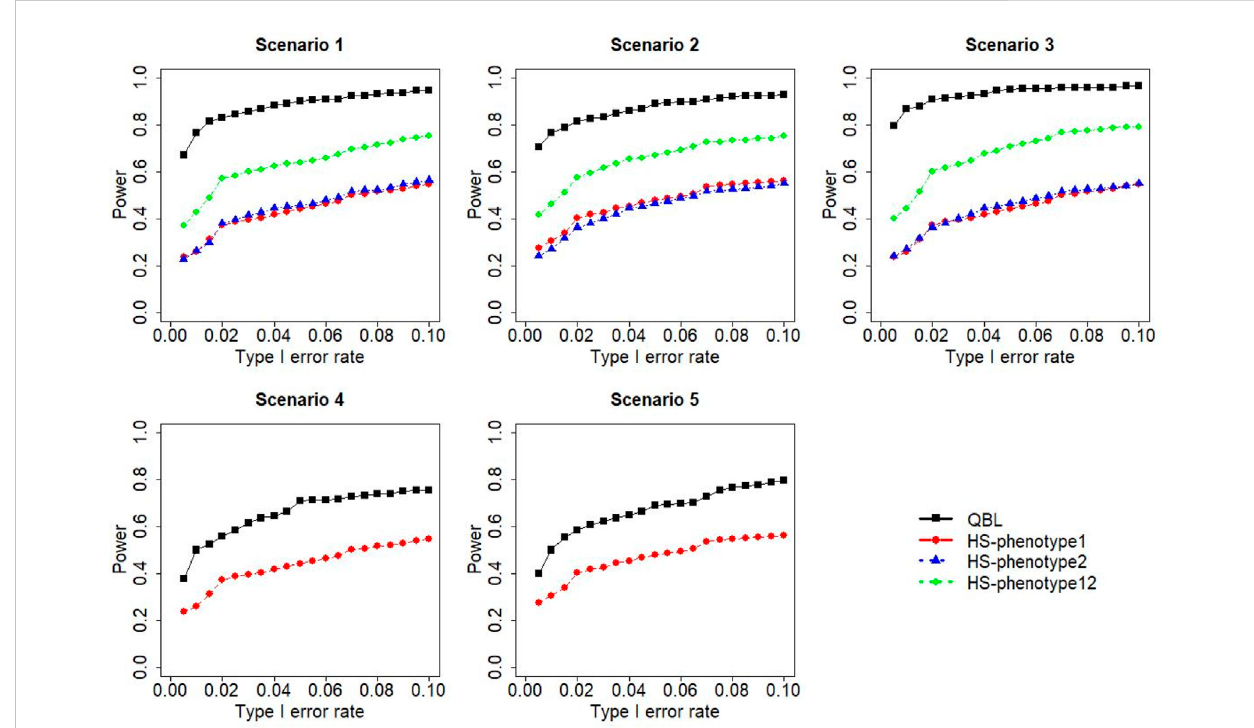
FIGURE 1 Simulation results under sample size 500, setting 1 (six haplotypes), and ρ = 0.1. Scenarios are shown in Table 1. HS, Haplo.score; phenotype12, phenotype 1 or 2.